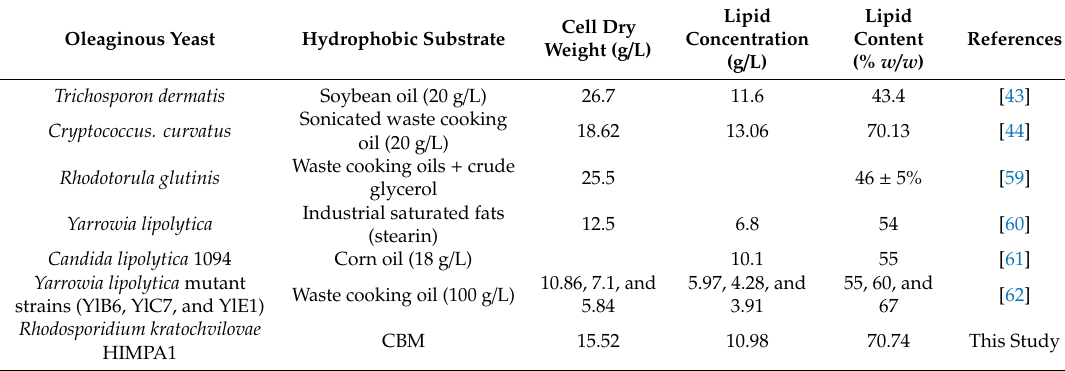
Table 1. Oleaginous yeasts cultivated on the hydrophobic